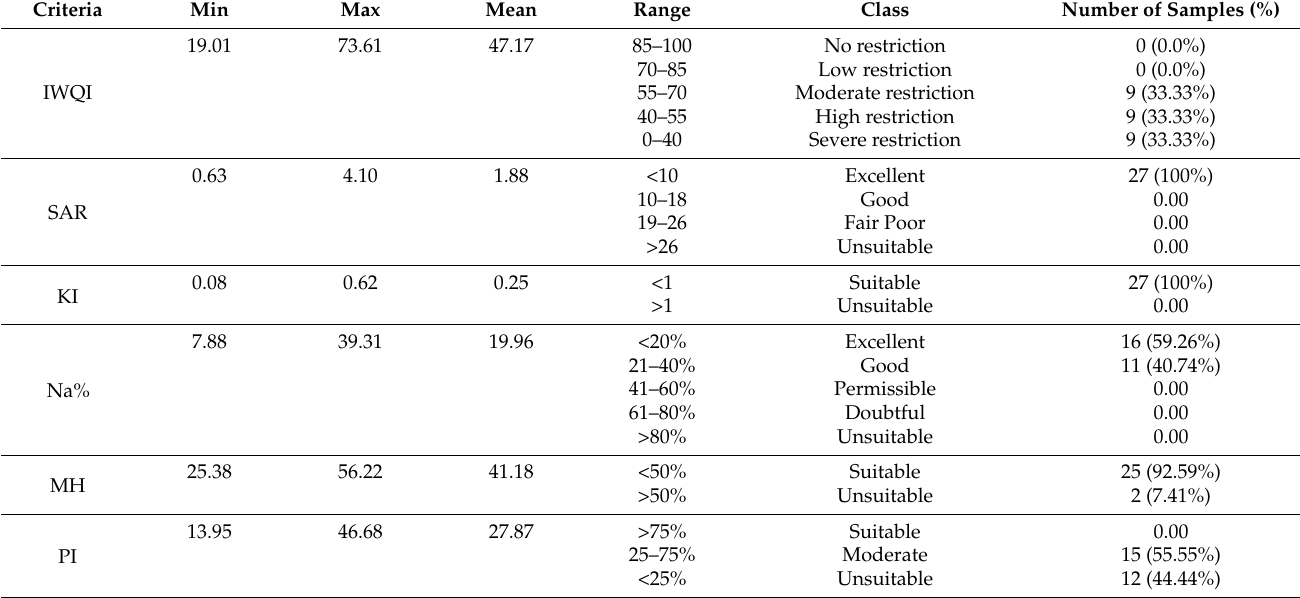
Table 4. Statistical analysis and classes of IWQIs.